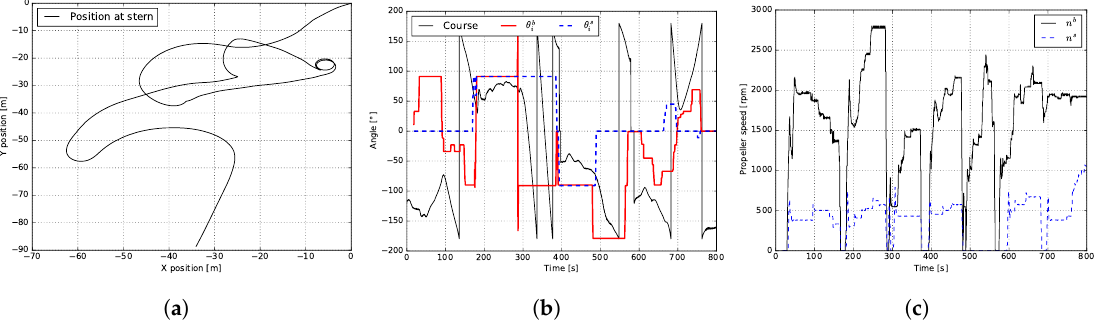
Figure 14. USV under I-SCC motion control in a lake (Rotselaar): ( a ) sailed trajectory, ( b ) internal actuation angles and USV course, and ( c ) actuation rotational